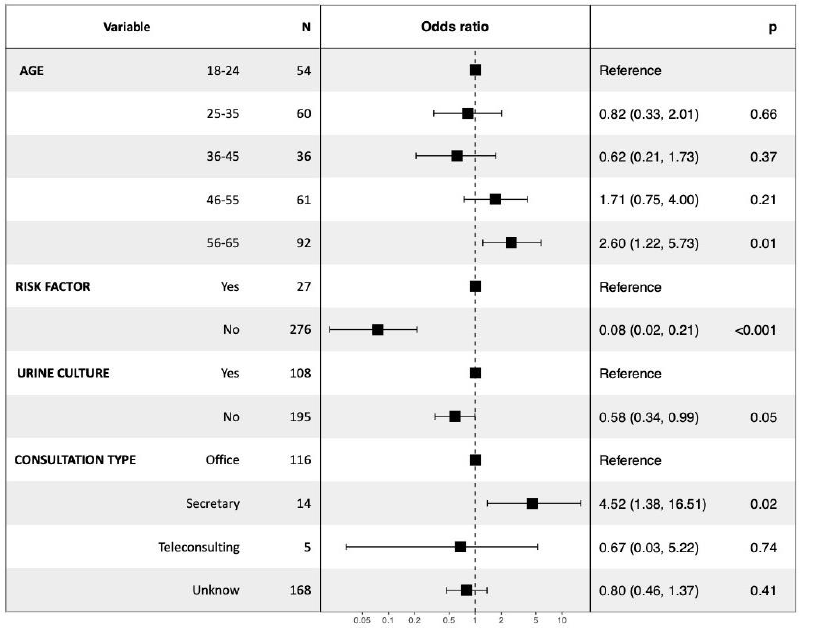
Figure 3. The impacts of the different factors which influenced the risk of non-compliance with antibiotic therapy for cystitis. Logistic regression was conducted with an α risk of 5%. A p -value of <0.05 was considered significant, a p -value of <0.01 was considered very significant, and a p -value of <0.001 was considered highly significant. A focus was placed on uncomplicated cystitis (n = 240). For this specific indication, the compliance between guidelines and antibiotic therapy was 66.3% (nature, dosage, and duration) (Figure 4). A dipstick test was performed in only 35 cases (14.6%), and a urine culture was performed twice as often (33.3%). Compliance with the antibiotic therapy and the urine examination led to a compliance rate of 5.8% (n = 14), ten times lower than com- pliance with the antibiotic prescription alone. Explanation of hygienic rules by the physi- cian reduced this compliance to 2.9% (n = 7) (Figure 3).